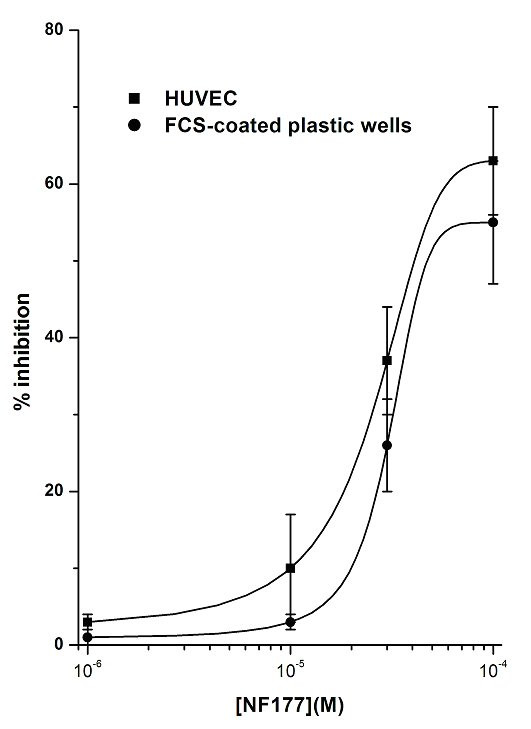
Effects of NF177 on PMN adhesion to FCS-coated plastic wells compared with PMN adhesion to HUVEC. PMNs were incubated with increasing concentrations (10-6–10-4M) of the tested compound for 10 min at 37°C and then challenged with FMLP 10-7M for 10 min. FMLP stimulation vs control was: 323 ± 33%. Data are expressed as percentage inhibition versus control adhesion, as means ± SEM; n = 5.